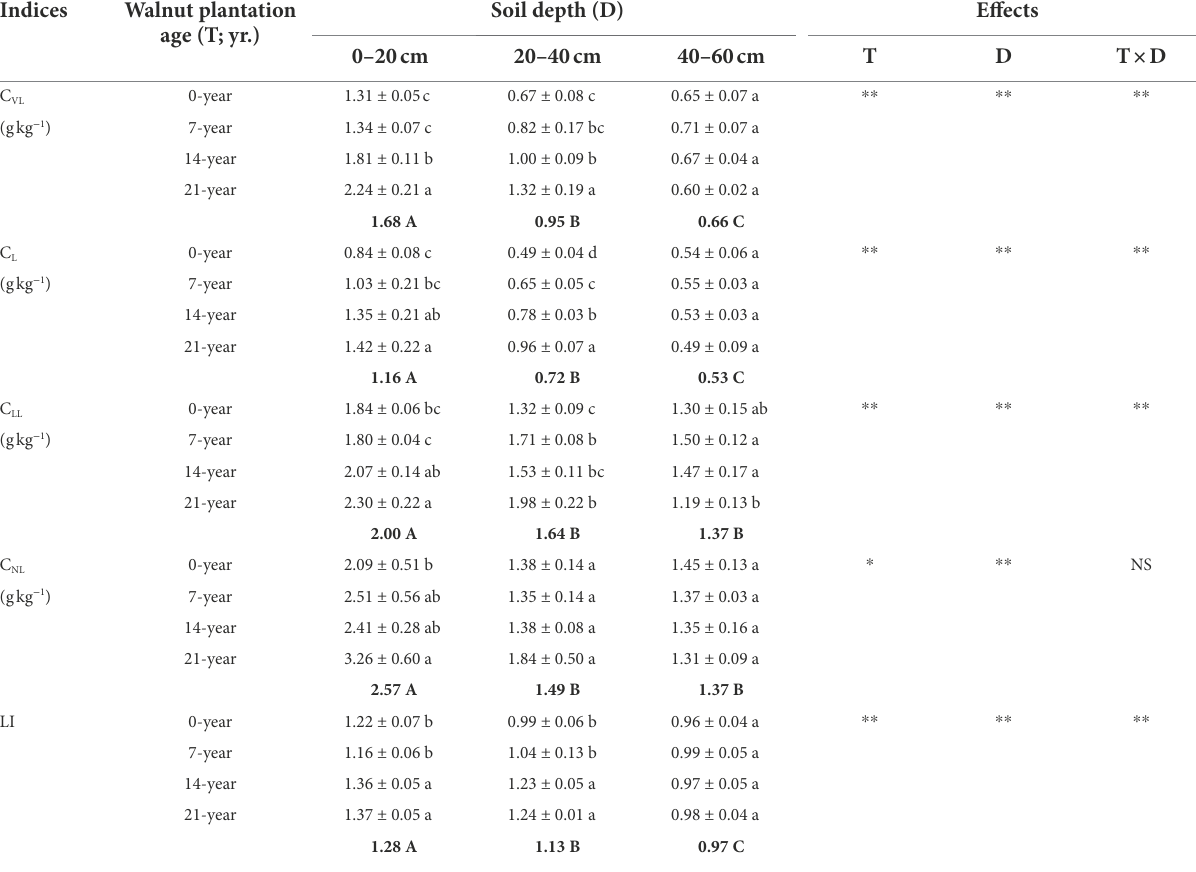
TABLE 2 Soil organic C pools and quality/lability at three soil depths (0–20, 20–40, and 40–60 cm) under different ages of walnut plantations. Indices Walnut plantation age (T;